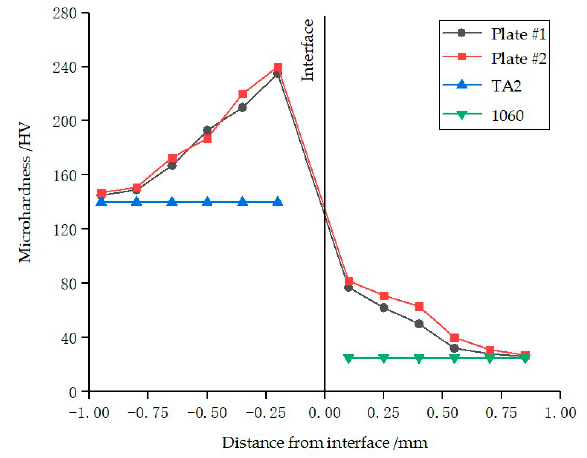
Figure 6. Microhardness profiles near the interface.